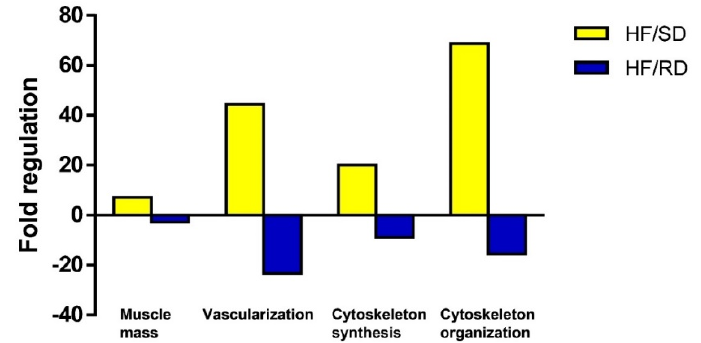
Figure 7. IPA ingenuity analysis of muscle-related processes. IPA analysis was used to predict whether these processes were increased or decreased as per the fold-change values of the genes involved and the influence of each individual gene on the biological function. Figure 7 shows how processes related to cytoskeleton and muscle mass are increased in HF/SD rats with respect to HF/RD ones.